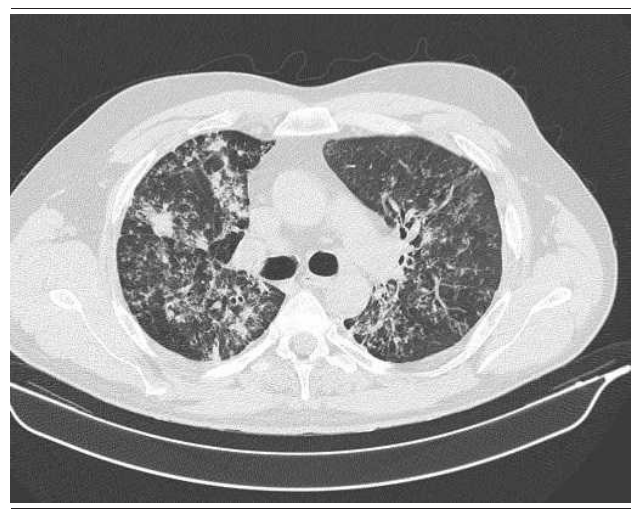
FIGURE – Chest CT Chest CT revealing extensive ground-glass opacities in both lungs; one can notice consolidations with air bronchograms, suggesting inflammatory/infectious process. CT: computed